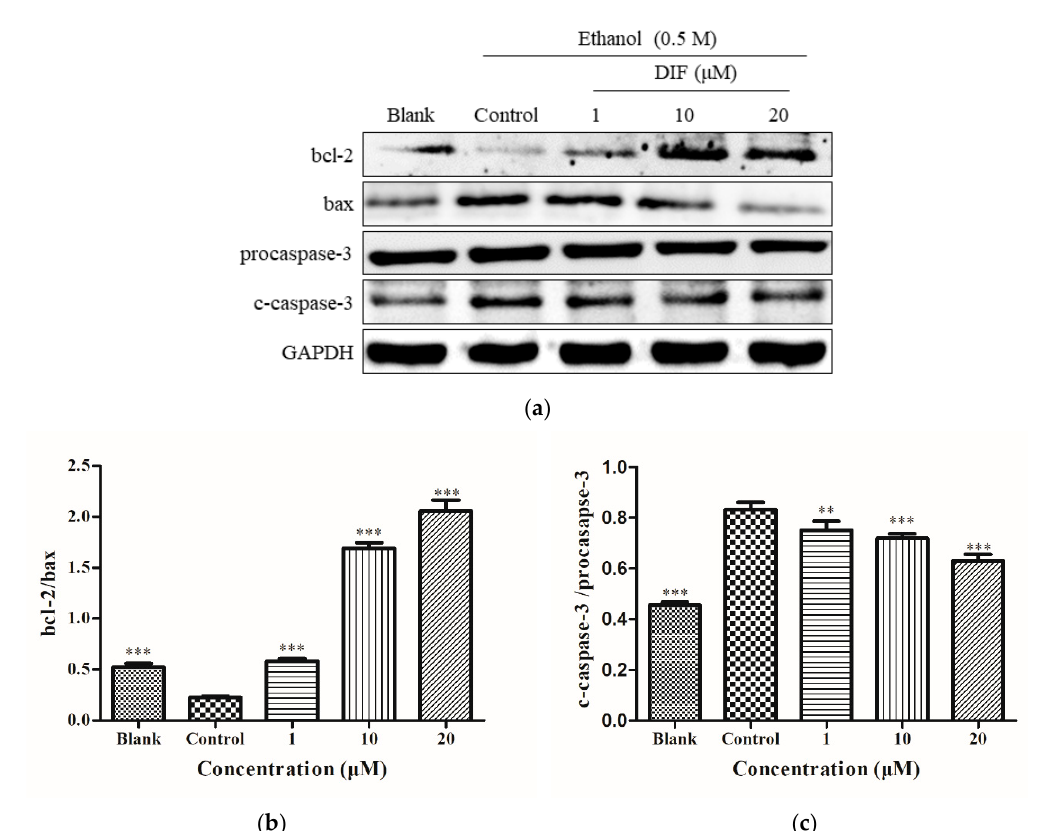
Figure 5. ( a ) The expressions of apoptotic proteins caspase-3, bcl-2, and bax. Cells were treated with DIF (1, 10, and 20 µ M) for 2 h, and then treated with 0.5 M ethanol for 24 h. ( b ) The ratios of bcl-2 and BCL2-associated X protein (bax) were calculated. ( c ) The ratios of cleaved c-caspase-3 and procaspase-3 were calculated. Data are shown as mean ± SD (n = 3). ** Compared with the control group, p < 0.01. *** Compared with the control group, p < 0.001.